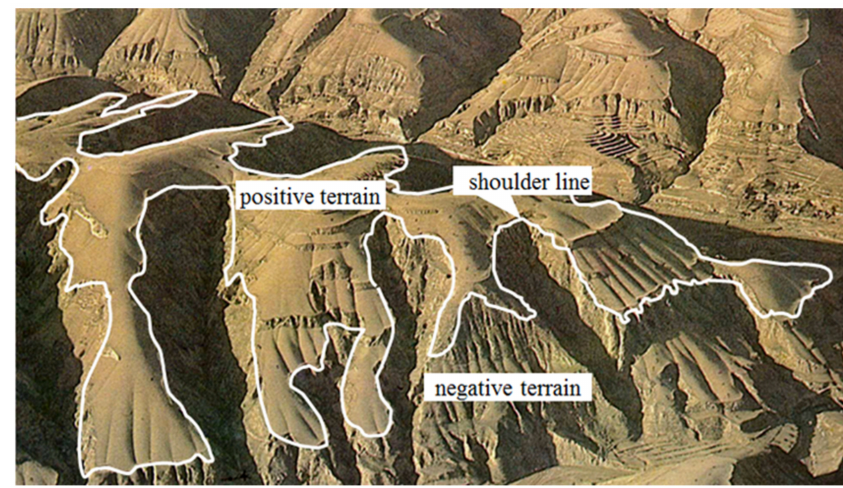
Figure 1. An illustration of shoulder line of the Loess